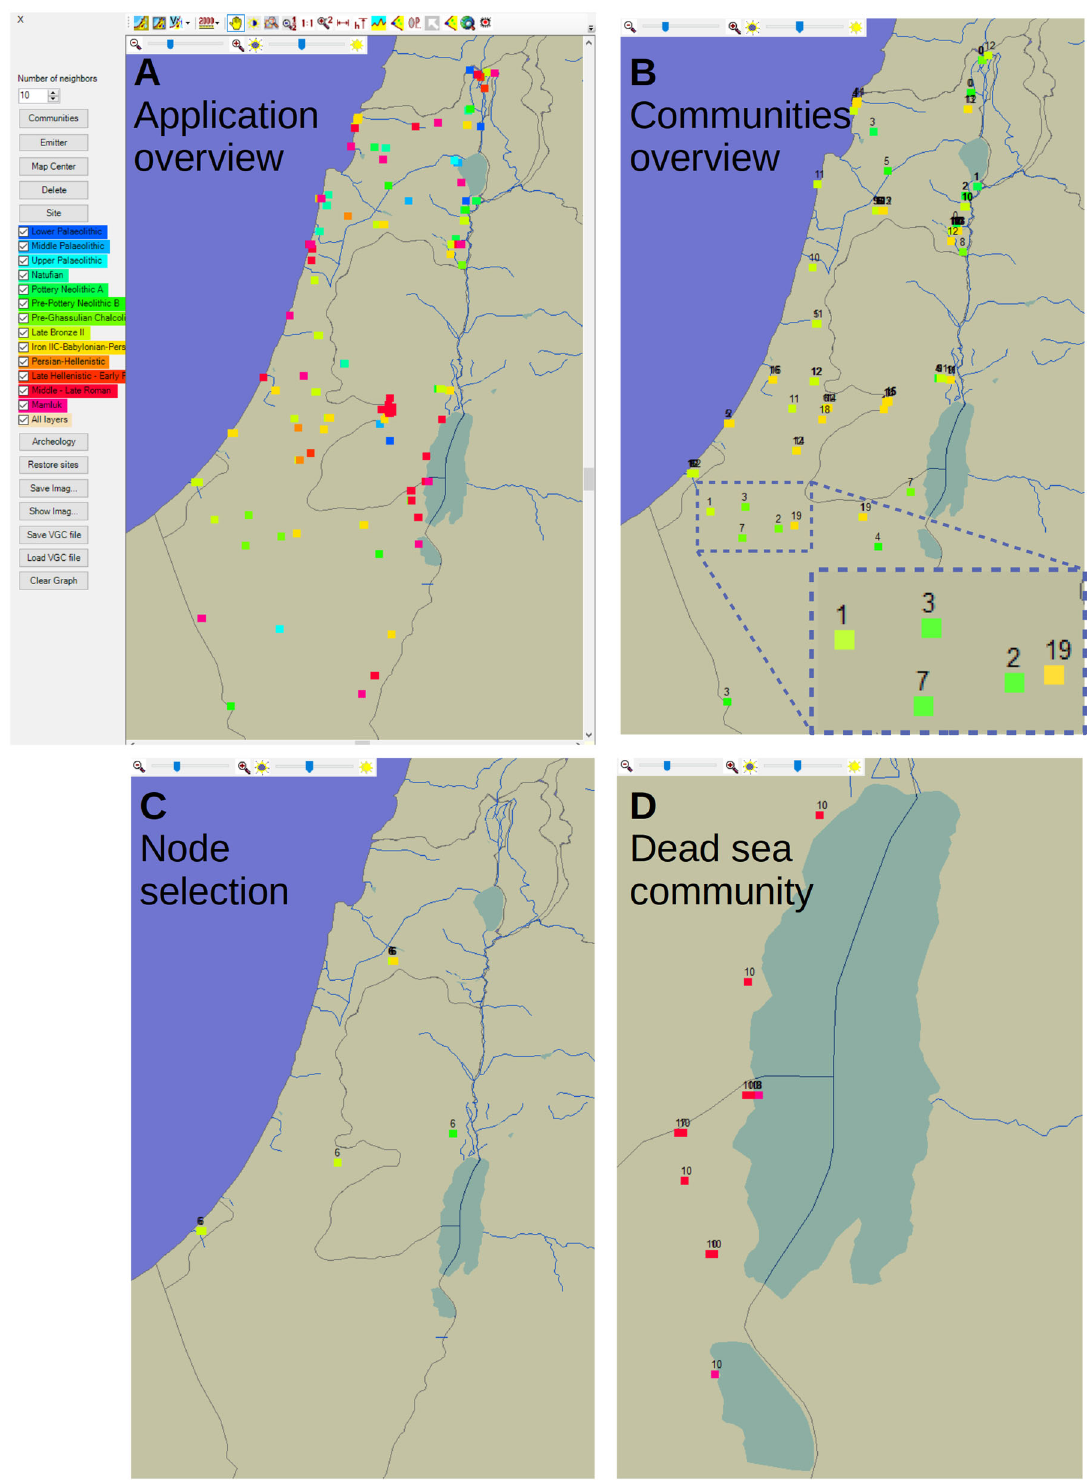
Fig. 3 Map application for interactive community detection. A Classes in the database are represented by coloured nodes, where the colour represents period. The menu on the left allows the user to alter the period groups presented and fi nd communities of interest. B Community detection of some period groups based on ten nearest neighbours. The number above each node represents its community. C Node selection mode: displays the community members of a selected class; In this example, they include (in period-site format) Iron I-Megiddo, Late Bronze Age II-Bet Shemesh, Late Bronze Age II- ’ Ujul, Late Bronze Age II-Megiddo, Late Bronze Age-Megiddo, Late Bronze Age- ’ Ujul, Middle Bronze Age II – Late Bronze Age-Megiddo, and Pre-Pottery Neolithic B-Jericho. D An example of a community clustered around the Dead Sea; it consists (in period-site format) of Early Roman-Horevot Mazada, Early Roman- Qumran Caves, Early Roman- ’ En Gedi, Roman-Horevot Mazada, Roman-Wadi Murabba, Roman-Mezad Rahel, Roman- ’ En Gedi, Roman-Nahal Mishmar Cave of the Treasure, Byzantine-Mesad Boqeq, and Roman-Nahal Hever.